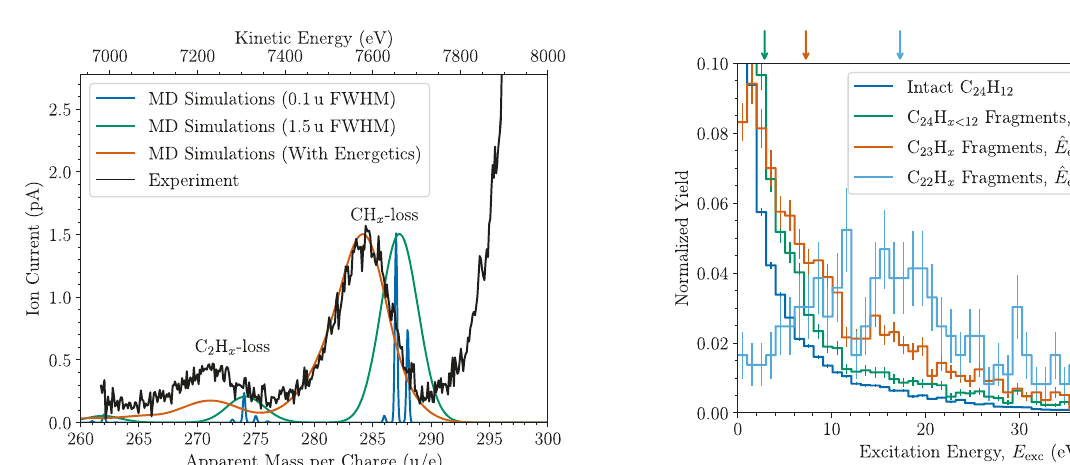
Fig. 2 Mass spectra from collisions between coronene (cations, 300 u/e) and He at center-of-mass energies of 105 eV. The experimental data is in black. The blue and green curves show the raw output from our molecular dynamics (MD) simulations, where one or more C atoms have been removed from the coronene molecule, with different resolutions (convolved with Gaussian pro fi les). The corresponding Full-Width Half Maximum (FWHM) values are given in the fi gure legend. The red data is the same as the green curve but includes information (from the simulations) on the translational motion of the products after the collisions. A detailed description of the simulations can be found in the Methods section. Source data are provided as a Source Data fi le.